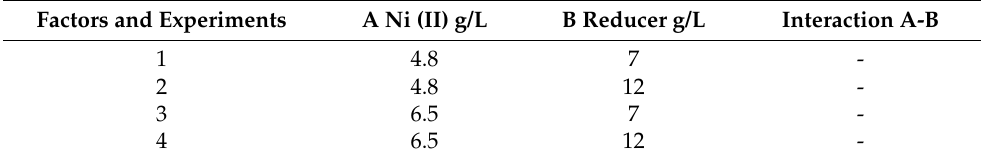
Table 5. Experimental matrix derived from dedicated L 4